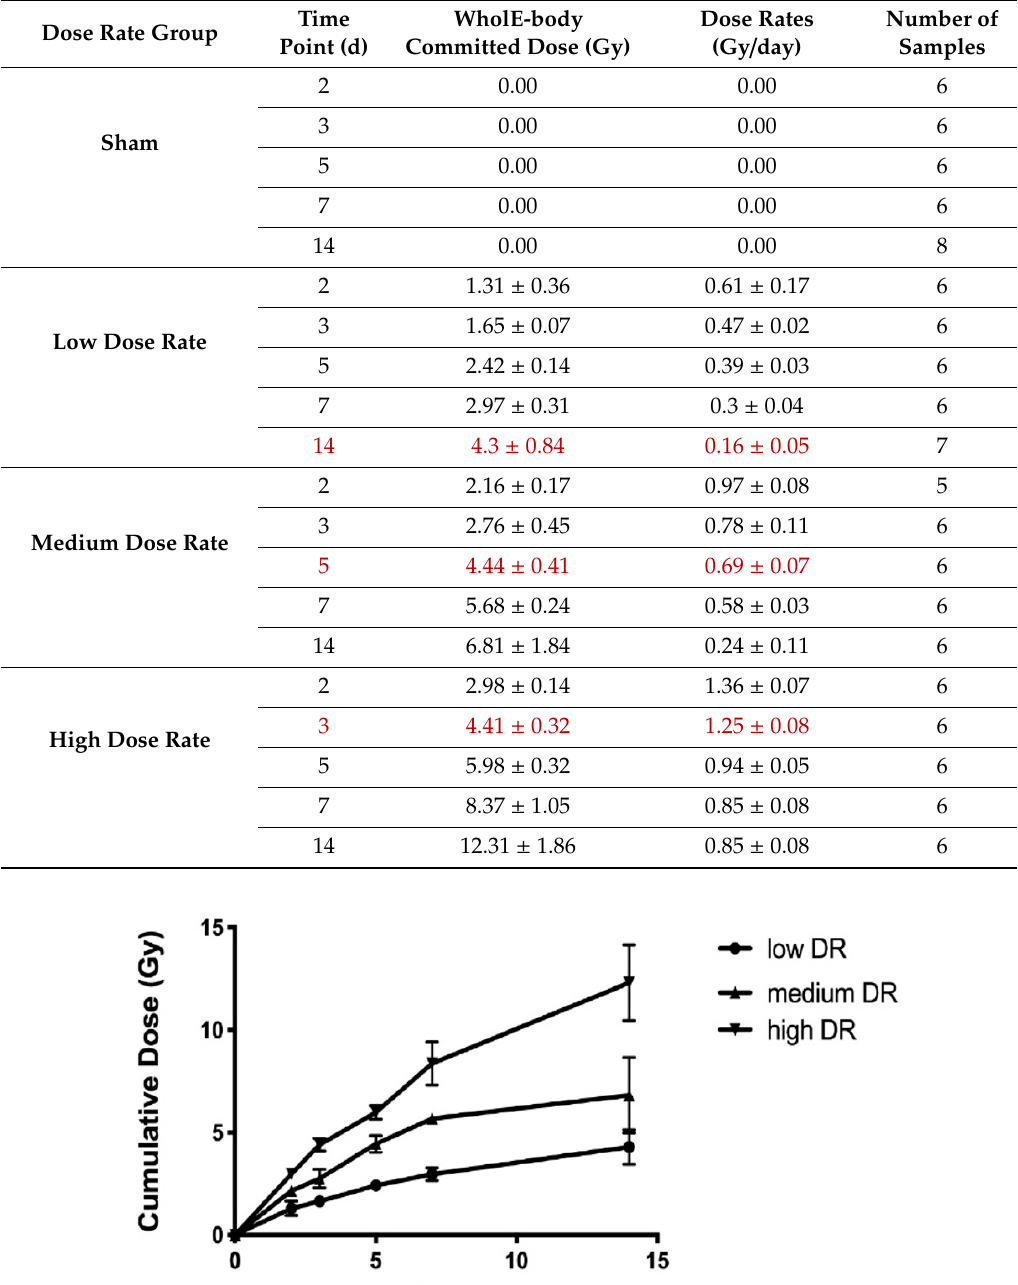
Table 1. Total-body dose (Gy) and dose rates (Gy / day) measured over the 14-day study period. The dose and the corresponding dose rates on the day when the accrued dose reached 4 Gy are marked in red for each group.